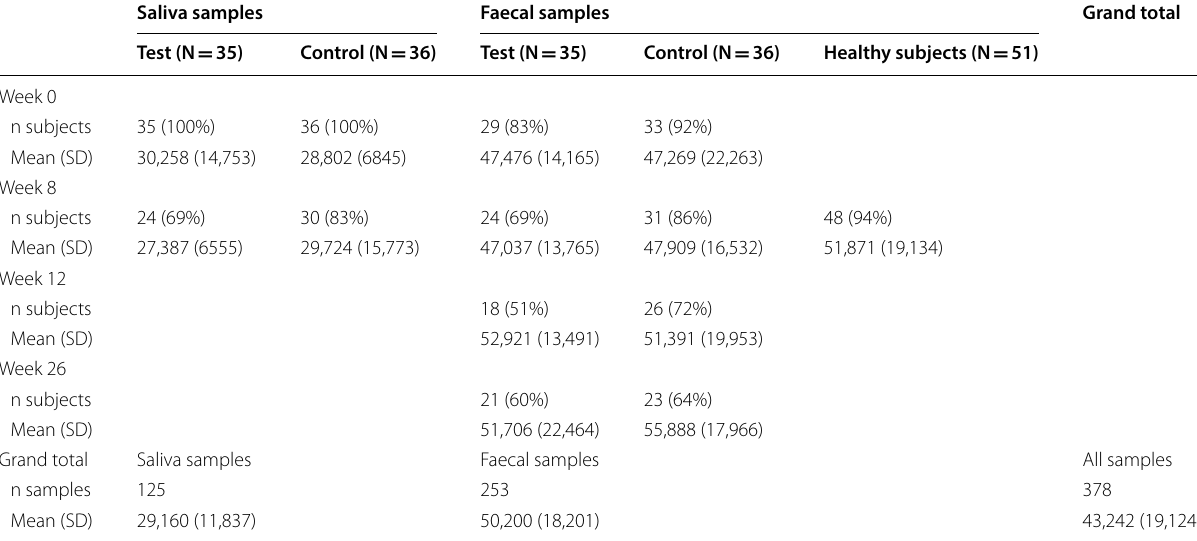
Table 1 Summary of saliva and faecal samples of subjects with CMA (ITT) and the healthy reference group (age-matched to week 8)